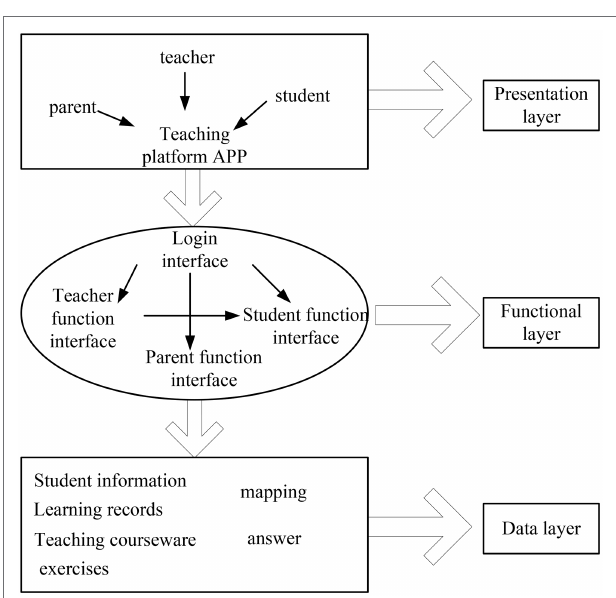
FIGURE 10 | Online English flipped classroom teaching mode.